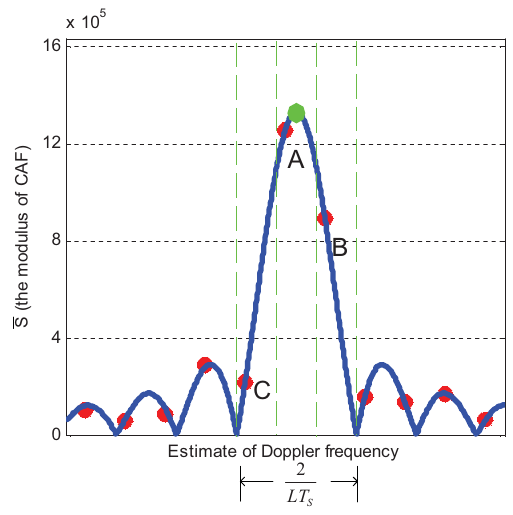
Figure 5. The plot of the column ( τ ≈ τ